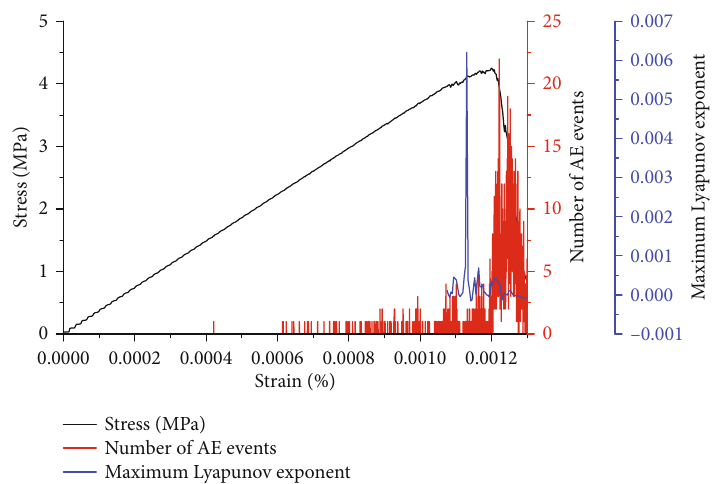
Figure 5: Stress-strain-number of AE events-maximum Lyapunov exponential variation diagram of specimen 2.